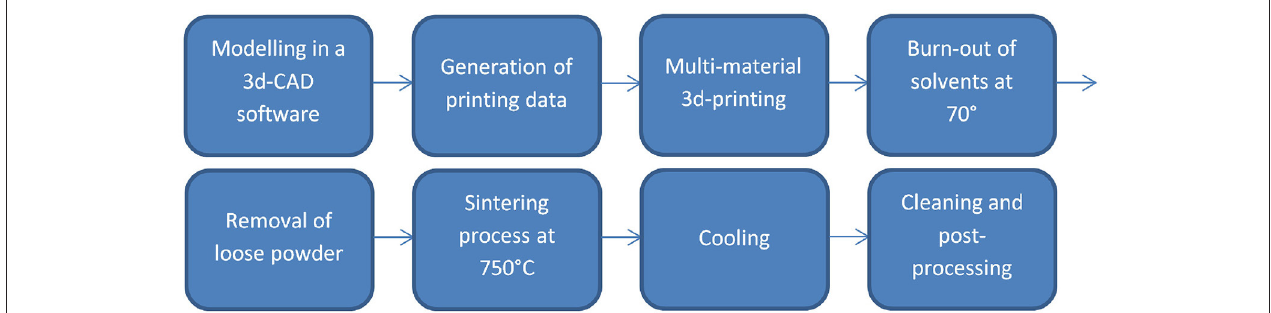
FIGURE 2 | Stages of the multi-material 3d-printing